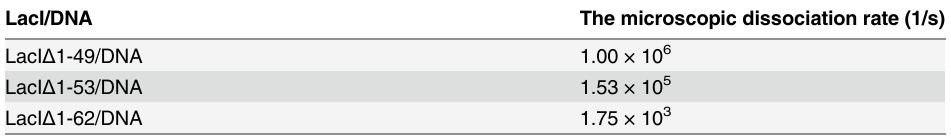
Table 2. The micro-dissociation rate constant of the LacI from the DNA.